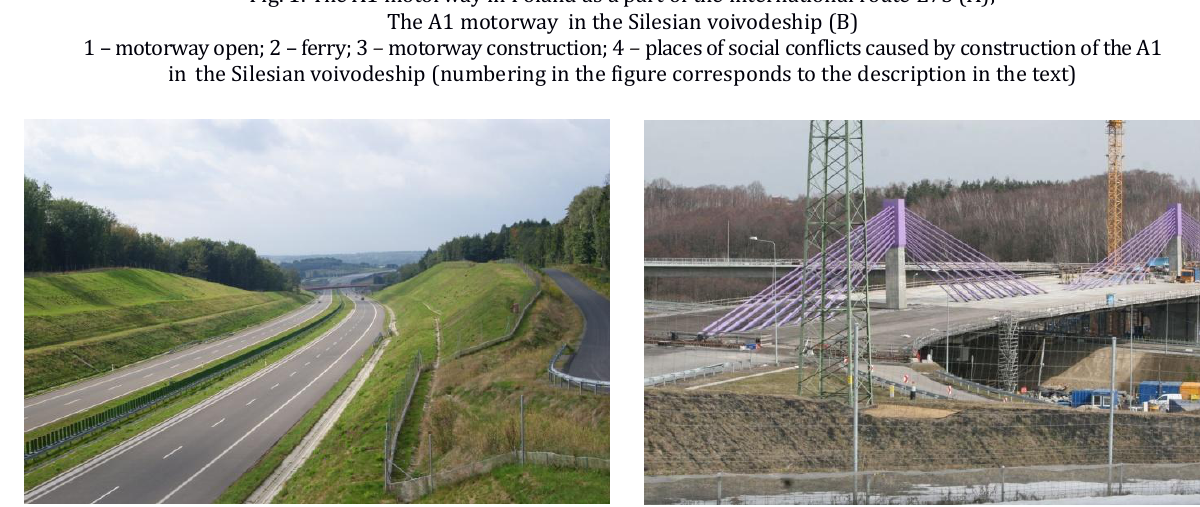
Fig. 3. The defectively constructed bridge in Mszana ( archives GDDKiA